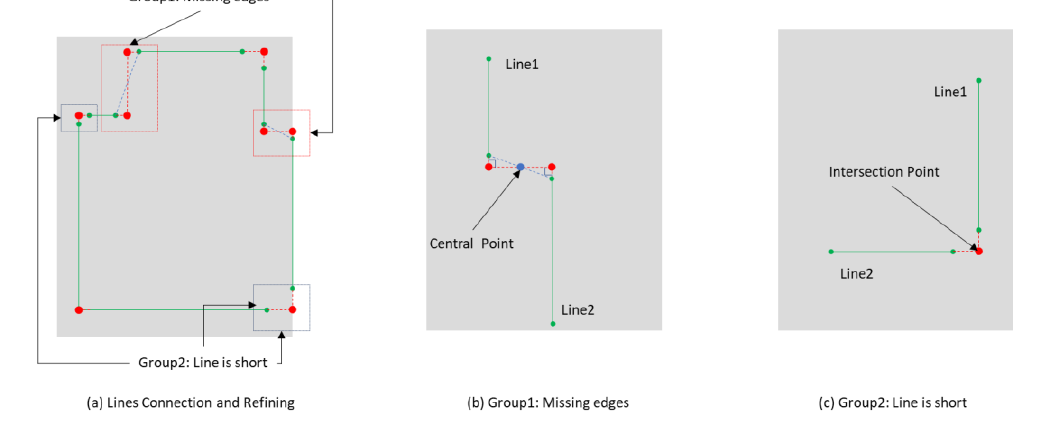
Figure 11. 2D wall lines connection and refining. Algorithm 2: 2D Wall Lines Connection and Refining